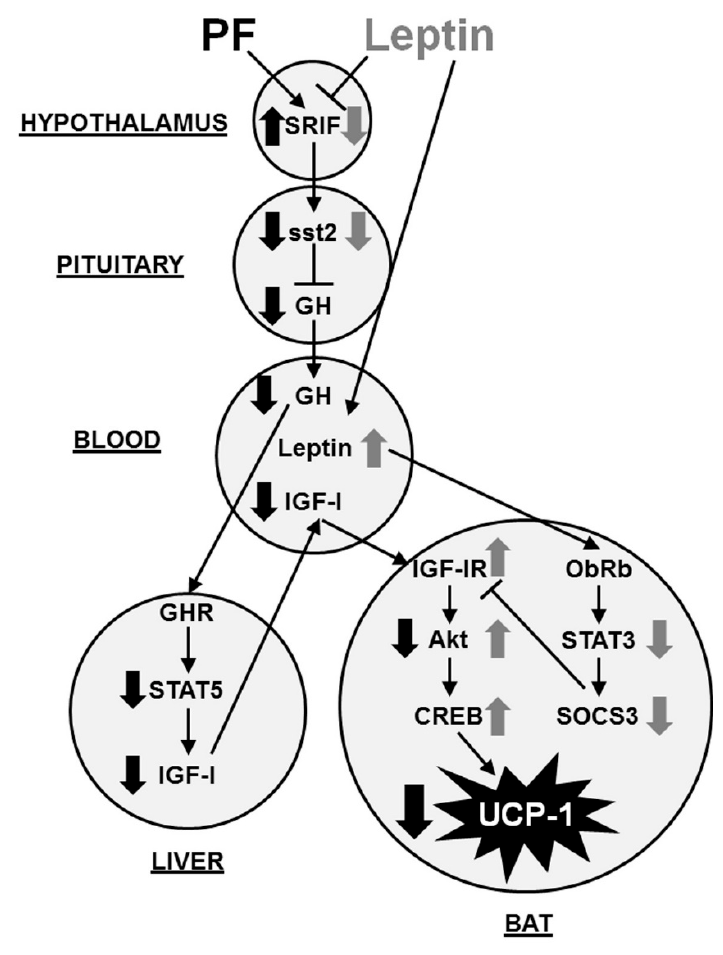
Figure 6. Model for modulation of the response of brown adipose tissue by leptin in a situation of negative energy balance. Pair-feeding increases SRIF and leptin infusion reduces it. SRIF inhibits GH synthesis and secretion, diminishing serum GH levels only in pair-fed rats. Thus, hepatic STAT5 activation is reduced and serum IGF-I levels are decreased in pair-fed rats. Chronic central leptin infusion increases serum leptin levels and reduces STAT3 activation, as well as SOCS3 levels in BAT. The association of SOCS3 to IGF-IR is decreased in leptin-treated rats, increasing IGF-IR activation and subsequent intracellular signaling. Thus, Akt and CREB activation is higher in leptin-treated rats, inhibiting the reduction in UCP-1 expression associated to a negative energy balance. Thin arrows indicate activation and blocked lines indicae inhibition. Thick black arrows denote pair-fed rats and thick grey arrows indicate leptin-treated rats. Akt, protein kinase B; BAT, brown adipose tissue; CREB, cAMP response element binding protein; GH, growth hormone; GHR, GH receptor; IGF-I, insulin-like growth factor-I; IGF-IR, IGF-I receptor; ObRb, long form of the leptin receptor; PF, pair-fed; SOCS3, suppressor of cytokine signaling 3; SRIF, somatostatin; sst2, somatostatin receptor 2; STAT, signal transducer and activator of transcription; UCP-1, uncoupling